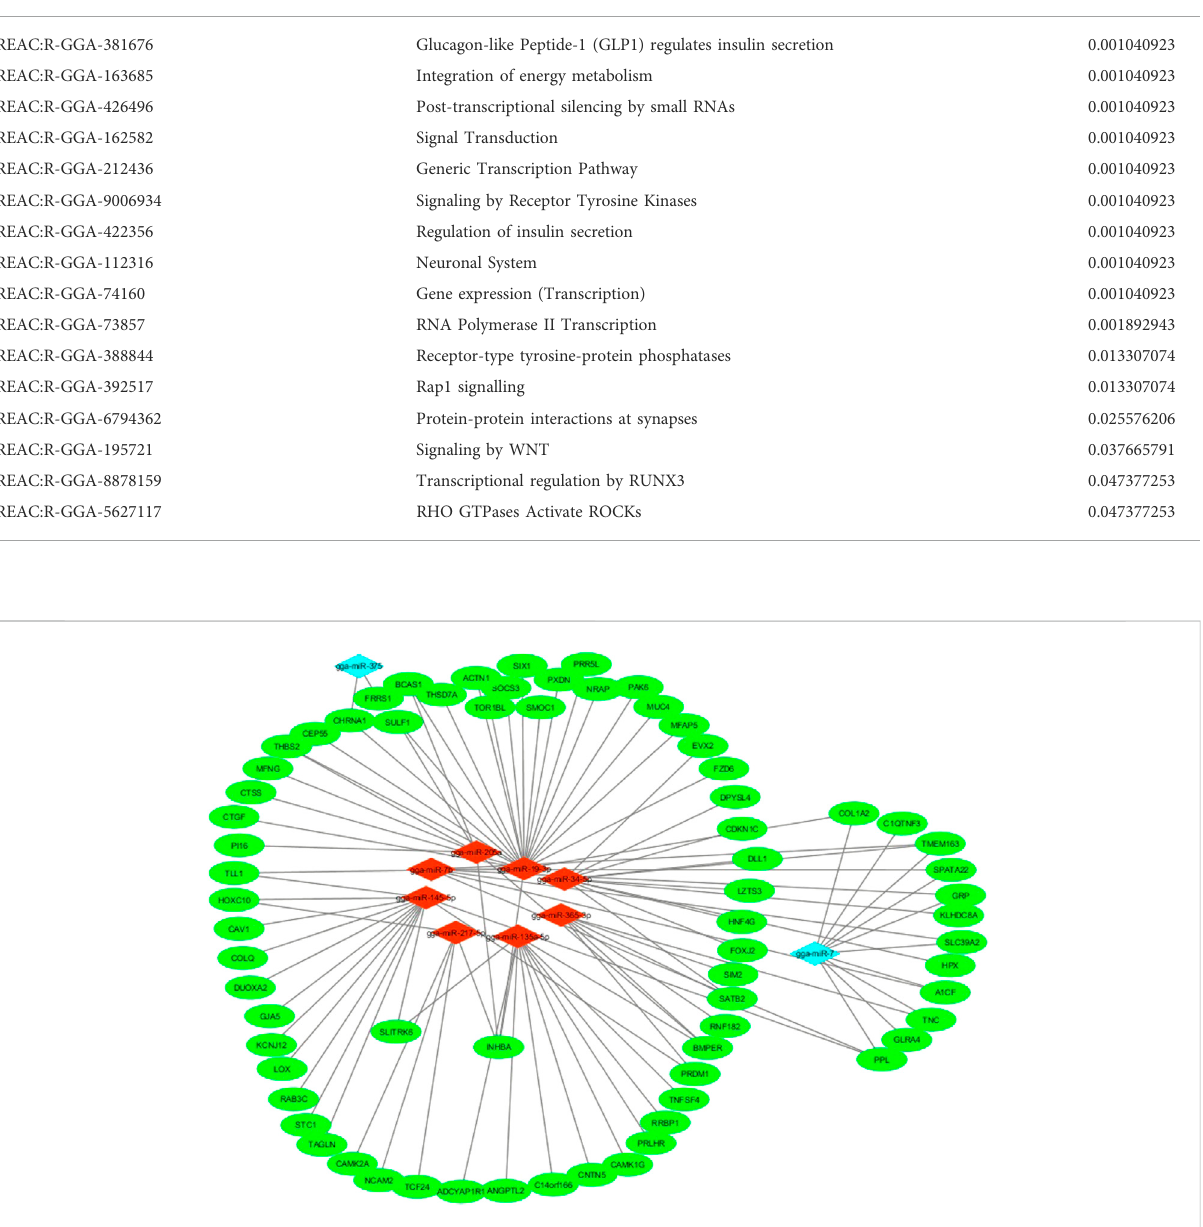
FIGURE 7 mRNA-miRNAregulatorynetworkinthepre-hierarchicalfolliclesofpurebredandhybridlayinghens.ReddiamondsrepresentmiRNAswithlow parent dominance expression; Cyan diamonds represent miRNAs with either high-parent dominance or over-dominance expression in the hybrids; Green ellipses represent target genes of miRNAs with non-additive